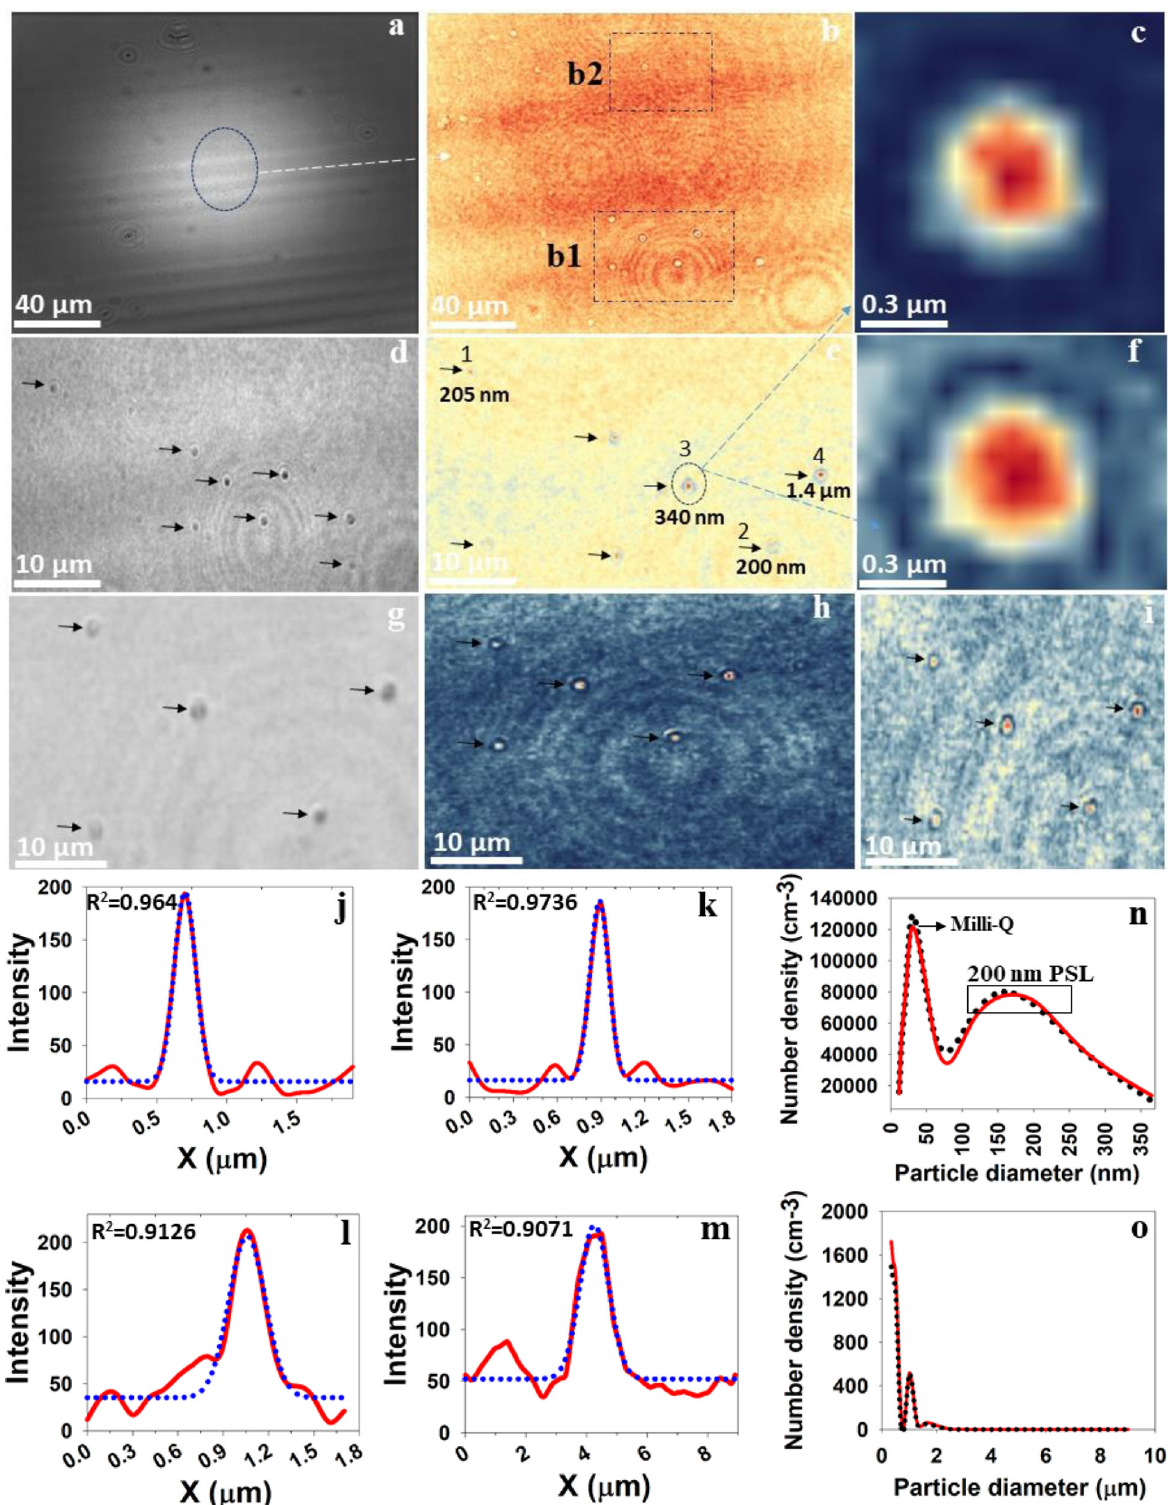
Fig. 3 Holographic reconstruction of 200nm PSL airborne particles. a Raw hologram; b zoomed-in region of a at Z = 1547 µ m. d , e Phase and intensity reconstruction of the region of box b1 in b . The arrow mark indicating the airborne PSL particles from nanosized to the larger diameter of particles. g – i Phase, intensity, and amplitude reconstruction of PSL particles in the region of box b2 in b , respectively. c , f Zoomed-in intensity and amplitude images of the PSL particle clearly showing the spherical shape. j – m Intensity crosscut of particles 1, 2, 3, and 4 levels in e , respectively. n , o The airborne PSL particle size distribution con fi rmation by the SMPS and the OPS. Various other S/TEM and their holographic reconstruction comparisons are included in Fig. 5. More intensity crosscuts of particles are shown in Supplementary Fig.